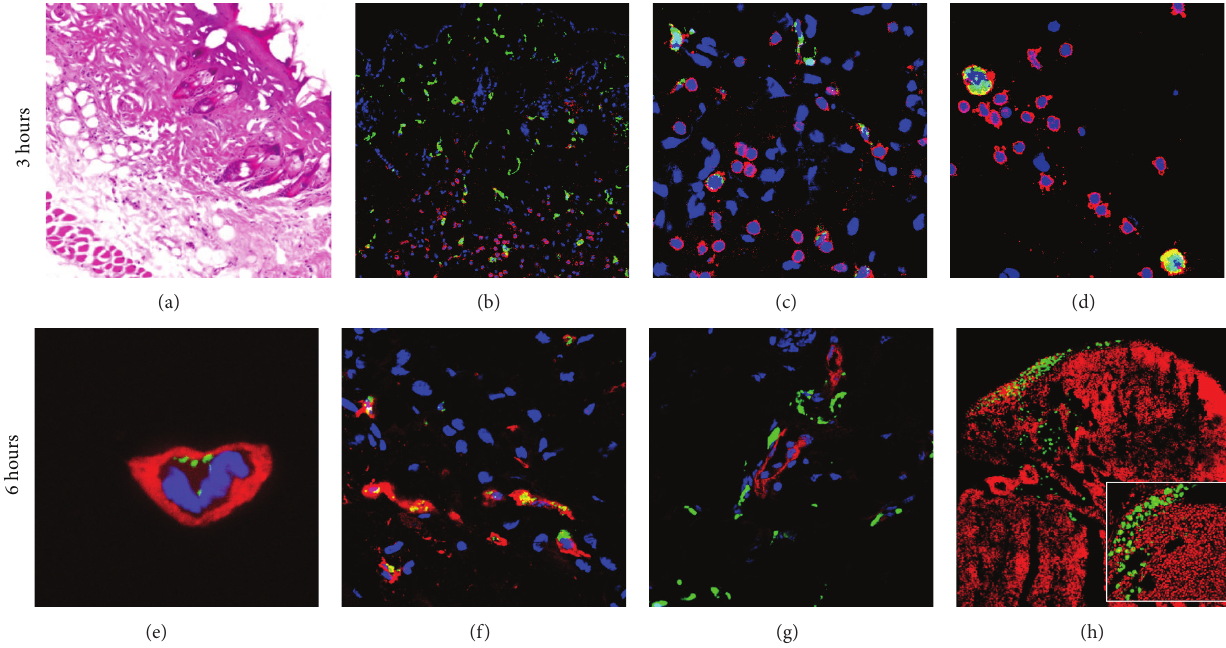
Figure1:ElectroporationeffectonFITC-dextranexpressionanddistributioninskin.ThreehoursafterintradermalinjectionofFITC-dextran followed by EP reactive cells that are recruited (a). Among these CD11b (red) cells incorporate FITC-dextran and are found in different skin layers ((b), (c), (d)). Six hours after vaccination, CD11c (red (e)) Lyve 1 (lymphatic vessel, red (f)) and CD31 (endothelial vessels, red (g)) cells are detected in the skin. FITC-dextran and nuclei are shown in green and blue, respectively ((b)–(g)). FITC-dextran incorporating cells are observed in draining lymph nodes 6 hours after treatment (h). Nuclei are shown in red (h). Images are representative of three independent